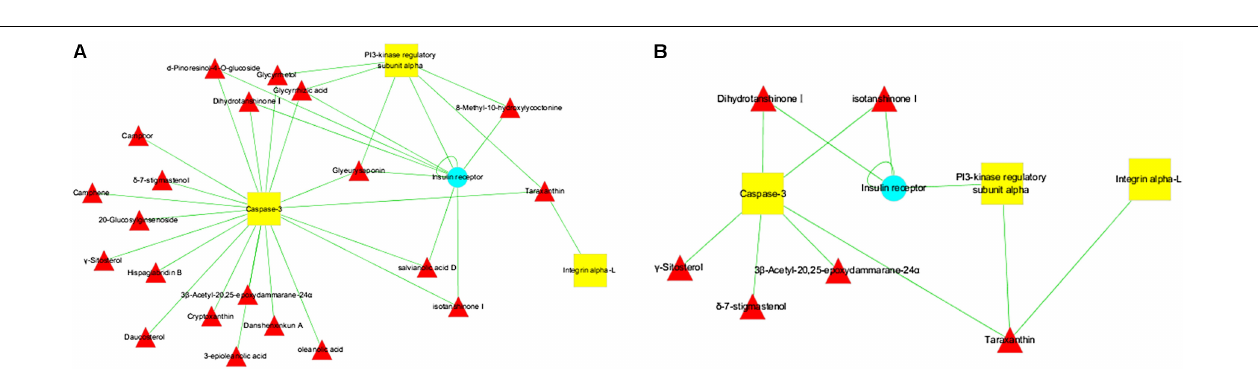
FIGURE 2 | Ingredients-targets-disease interaction network of SCG. (A) The main network of SCG. (B) The sub-network with direct targets and the corresponding ingredients. The red triangles represent the potential active ingredients of SCG; the blue dot represents the indirect targets of SCG; the yellow dots stand for the targets of the special disease; and the purple dots represent the interaction targets of the specific disease and drugs.